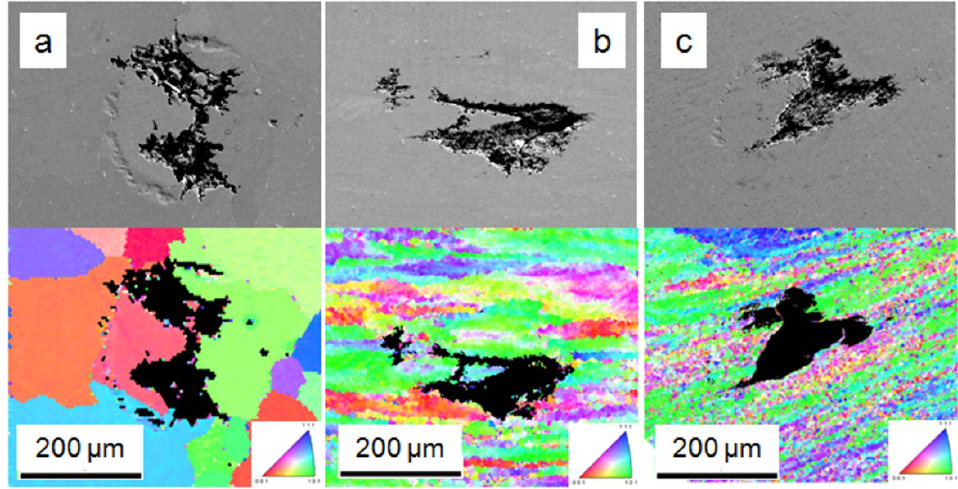
Figure 6. Corrosion appearance after micro-scale potentiodynamic polarization of the ( a ) cast condition; ( b ) extruded condition (extrusion direction is horizontal) and ( c ) in a shear band of the ECAP